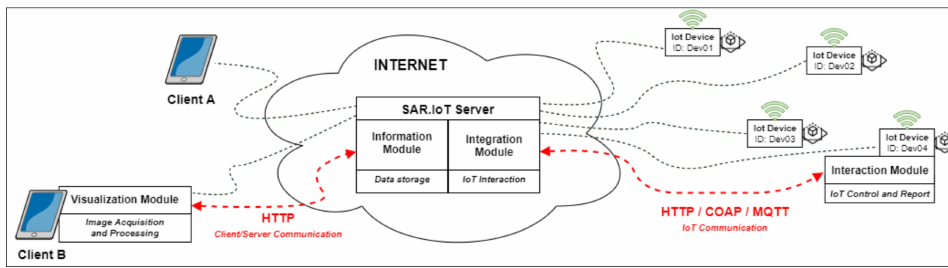
Figure 8. Communication